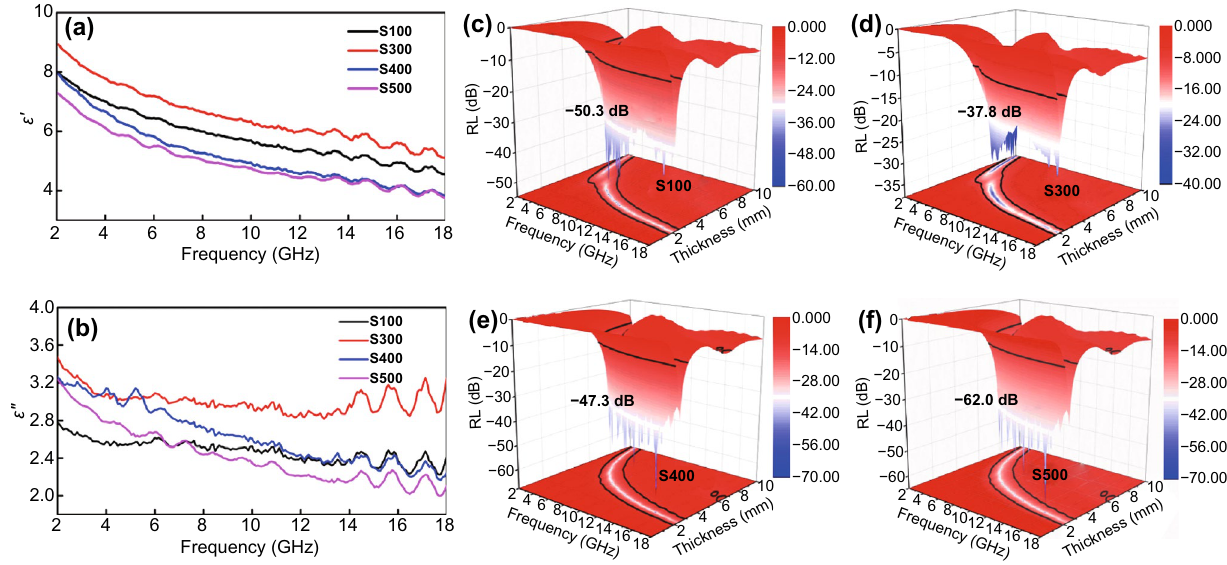
Fig. 9 The curves of dielectric parameter ( a, b ) for S100, S300, S400, S500; the 3D reflection loss of S100 ( c ), S300 ( d ), S400 ( e ), S500 ( f